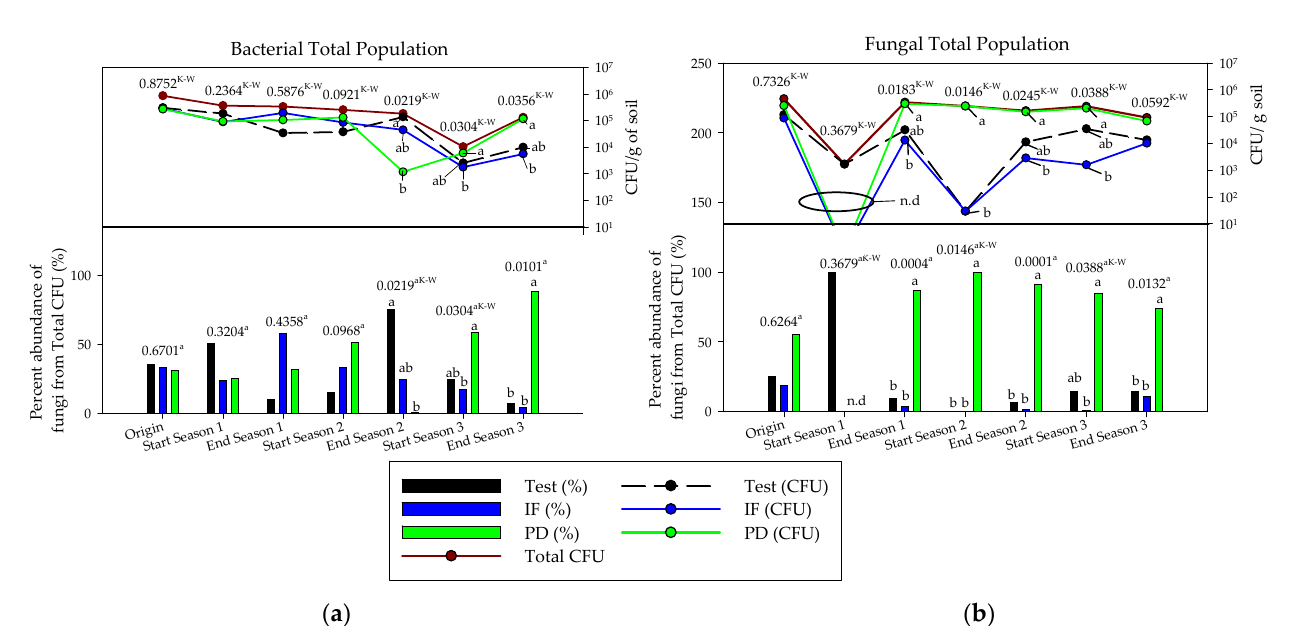
Figure 2. Soil microbiota in the three years of study (September–April cycles) as a function of crop nutrition: ( a ): total bacterial population (CFU and percentage abundance); ( b ): total fungal population (CFU and percentage abundance). inorganic fertilization (IF; n = 4); tomato plant debris (PD; n = 4); no fertilization (Test; n = 4). N.d: non detected. Values (average). Different letters above the bars and in the evolution lines indicate significant differences. ( p ≤ 0.05, Tukey’s HDS (cid:0) √ (cid:1) x test), a : arcsen ; K-W : Kruskal–Wallis